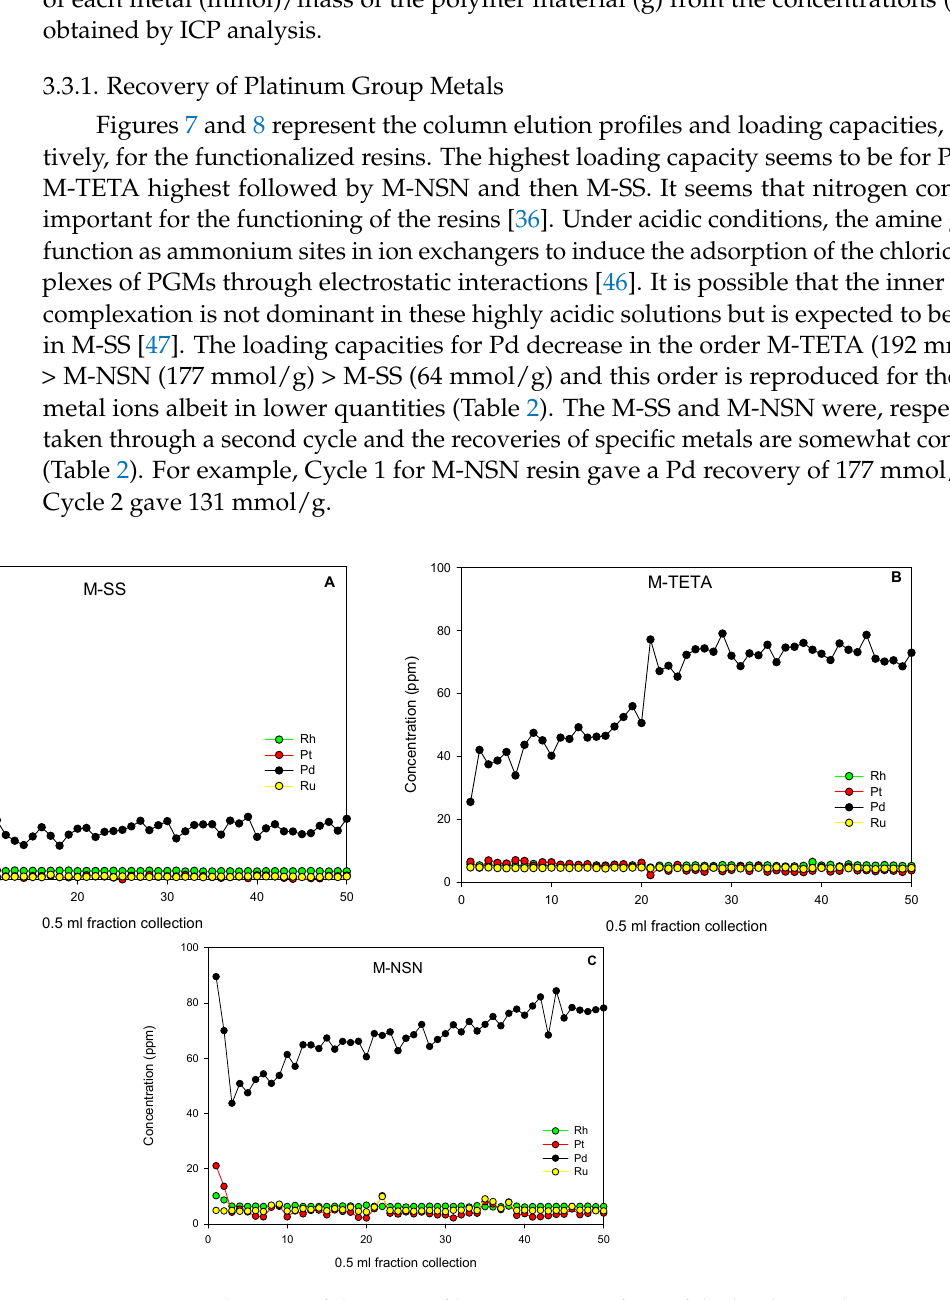
Figure 7. PGMs adsorption/elution profiles using 5 mL of 1M of the leachate solution, 0.3 g resins: ( A ) M-TETA, ( B ) M-SS and ( C ) M-NSN were, respectively, washed with 1 M HCl and eluted with 3% w/v thiourea at ambient temperature.